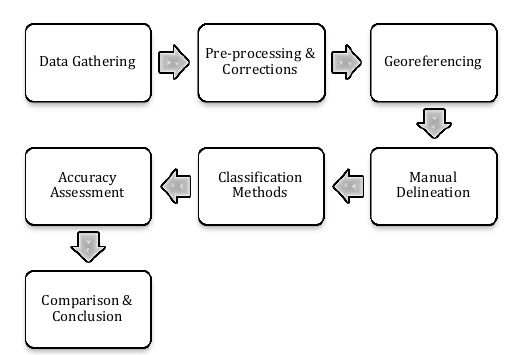
Figure 2 – General flow of procedure done in the research Figure 2 illustrates the general flow of the procedure done